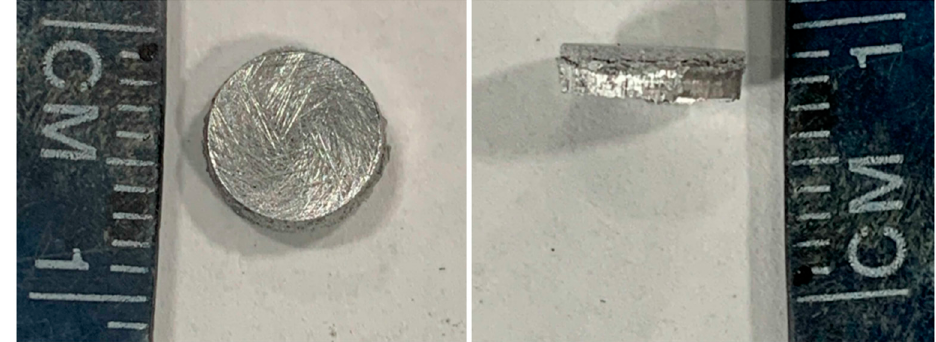
Figure 12. Example of aluminum green body formed by compactibility testing.